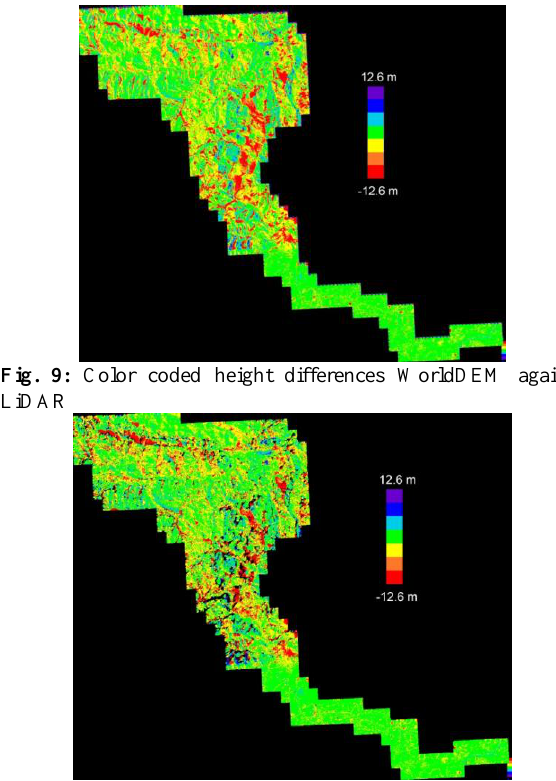
Fig. 10: Color coded height differences of filtered WorldDEM against LiDAR, black in project area = deleted by filtering